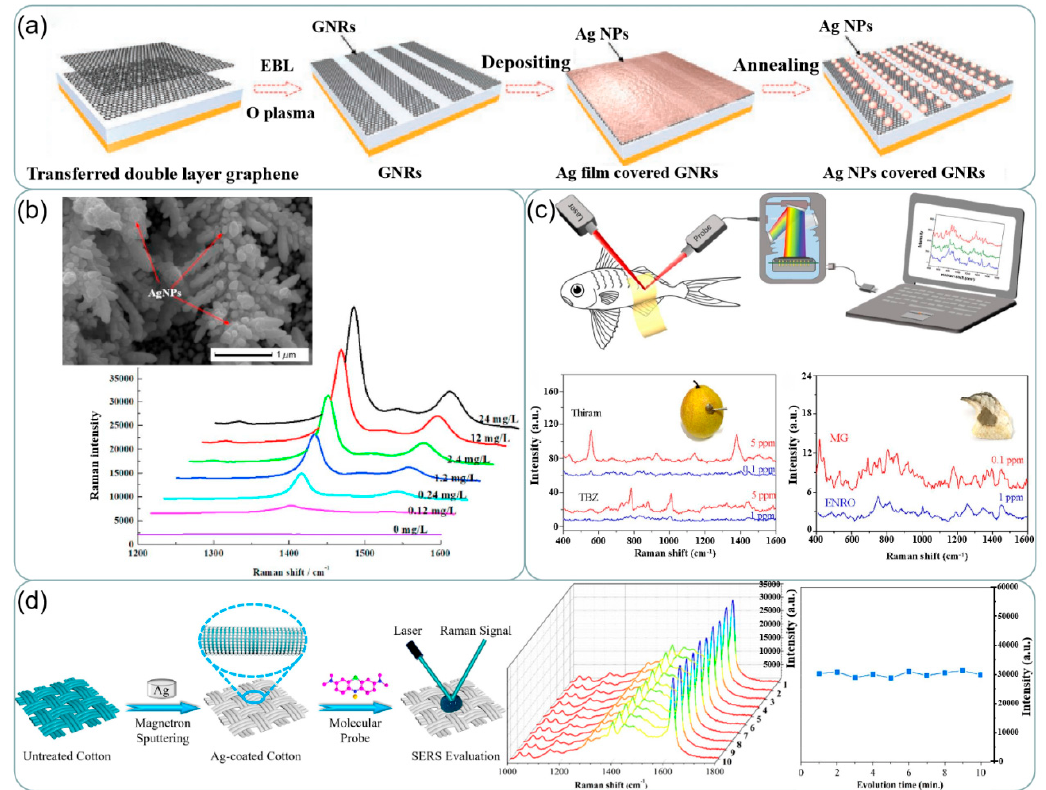
Figure 13. ( a ) Fabrication processes of the shared substrate. Reprinted with permission from Ref. [138]. Copyright 2021, Small. ( b ) SEM images and EDX spectroscopy of Ag-AuNDs substrate. SERS spectra of thiram with a concentration of 0–5 mg/L and 0–24 mg/L. Reprinted with permission